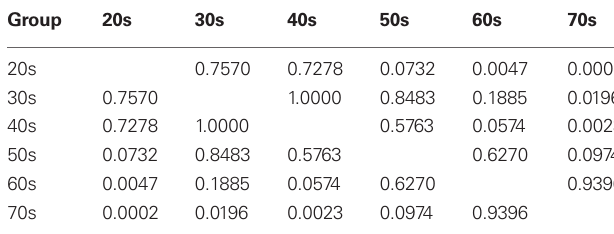
Figure 1 | Performance on the emotional inhibition test across age group. Colored bars represent means for performance in each condition of the emotional inhibition; error bars reflect standard error of the means. Age groups are on the x axis. Note general declines in performance with age, but relatively better performance on the Emotional Inhibition, as compared to the Neutral Inhibition condition, with advancing